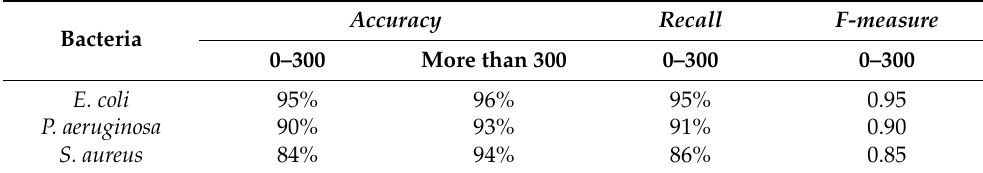
Table 4. Accuracy , recall and F-measure results sorted by bacterial species.